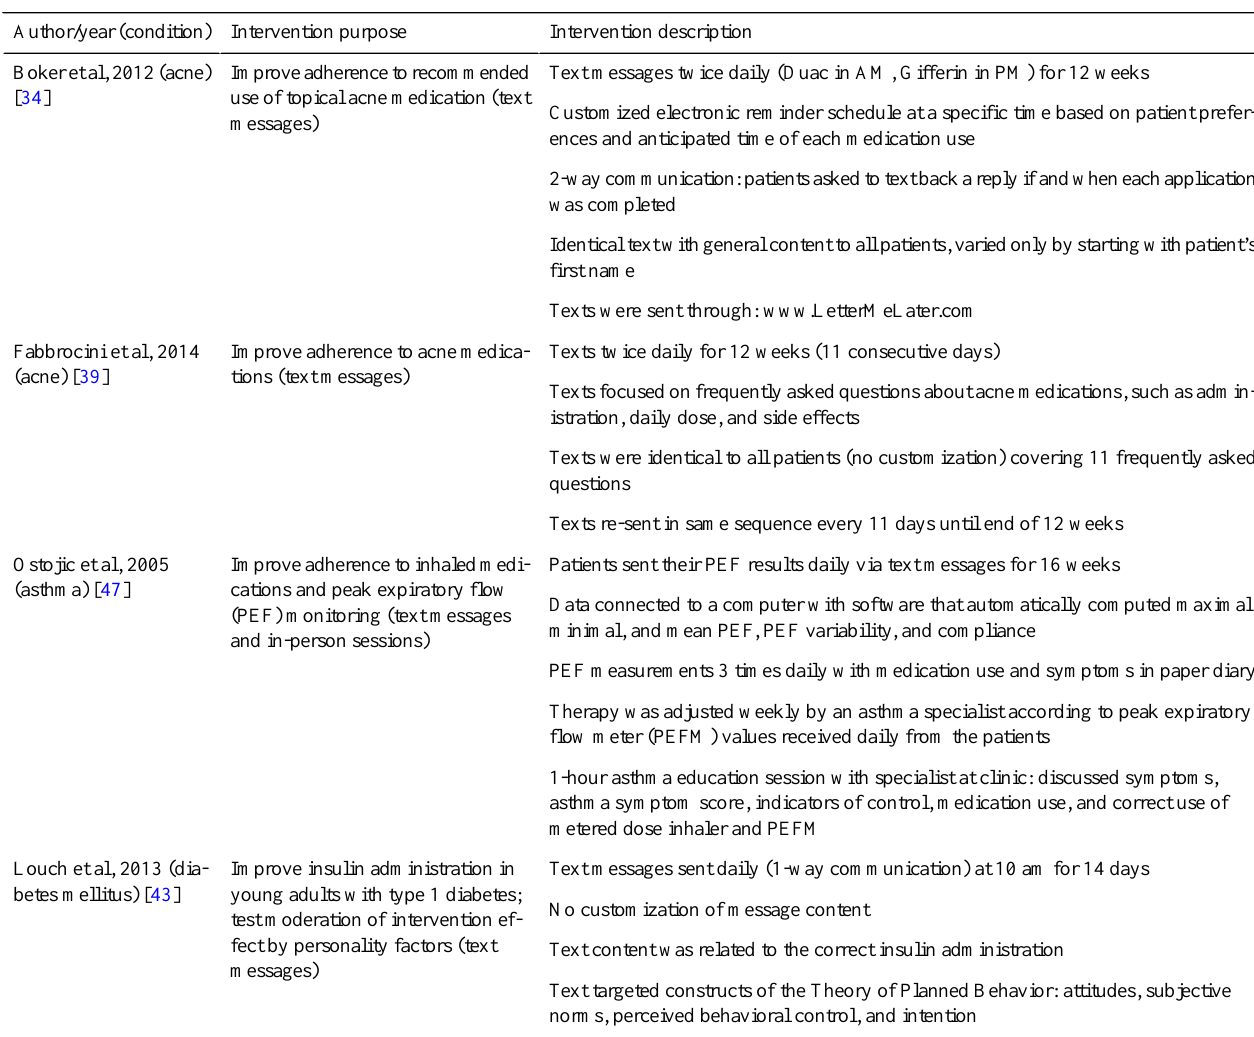
Table 2. Description of text message interventions.